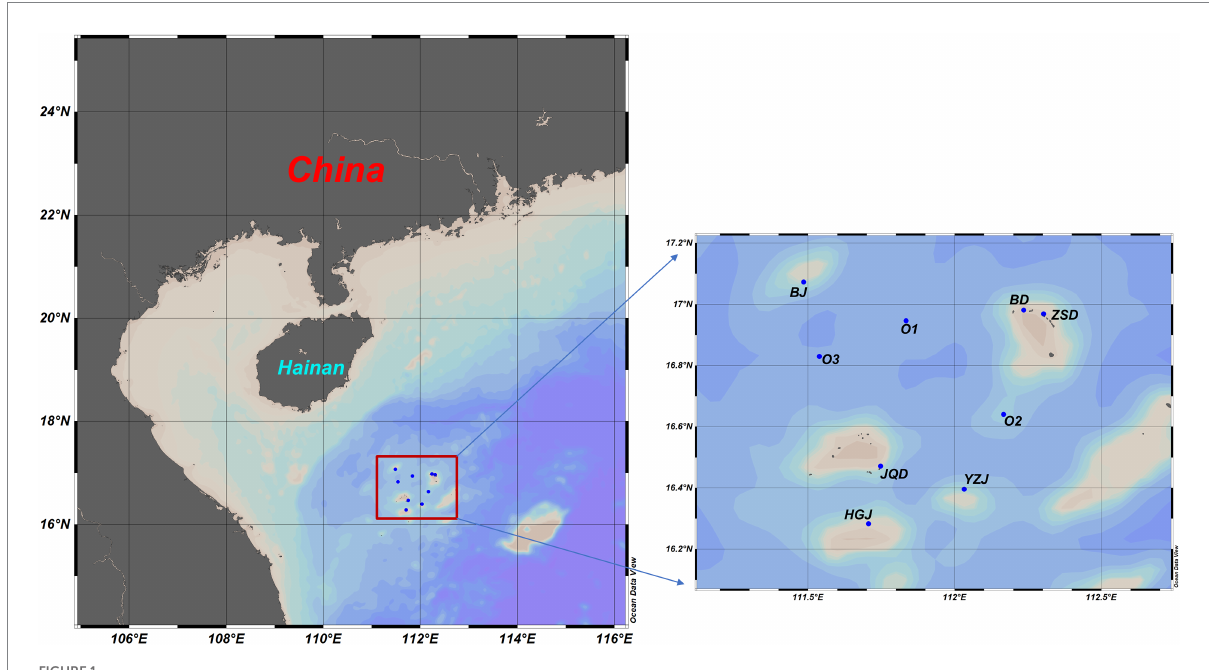
FIGURE 1 Investigation region and sampling sites in the Xisha coral reef